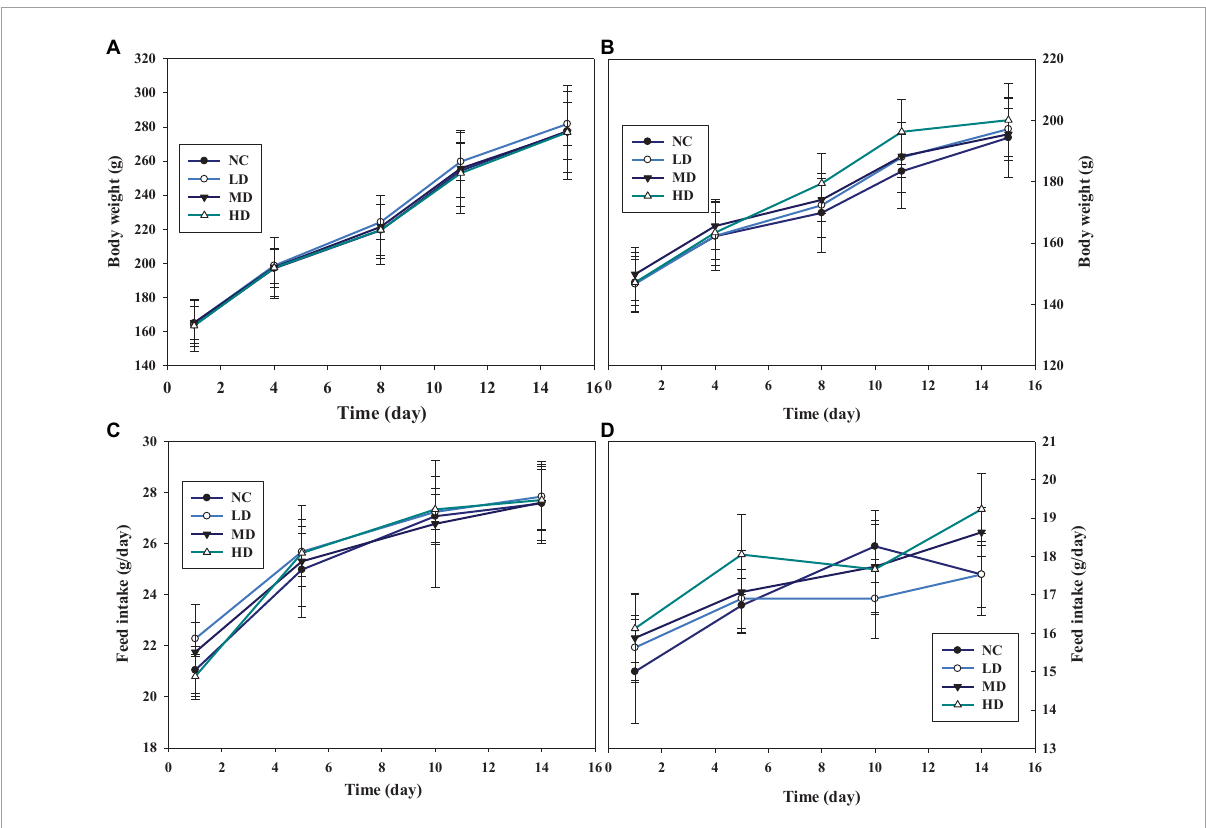
FIGURE3 The effects of AECPL on the body weights and feed intake on Sprague-Dawley (SD) rats in acute toxicity study. (A,B) refer to the body weights of males and females, respectively; (C,D) refer to the feed intake of males and females, respectively.